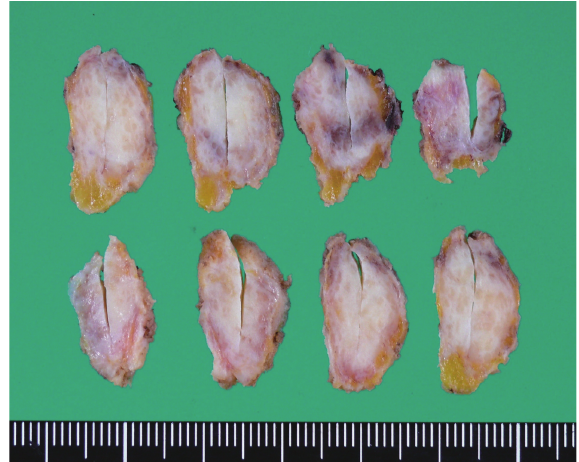
Figure 3: Macroscopic cut sections of the tumor A well-defined elastic hard mass, 2.5 × 2 × 1cm, was excised from the A area of the right breast. Meshwork composed of whitish fibers separating atrophic fatty breast tissue was observed.